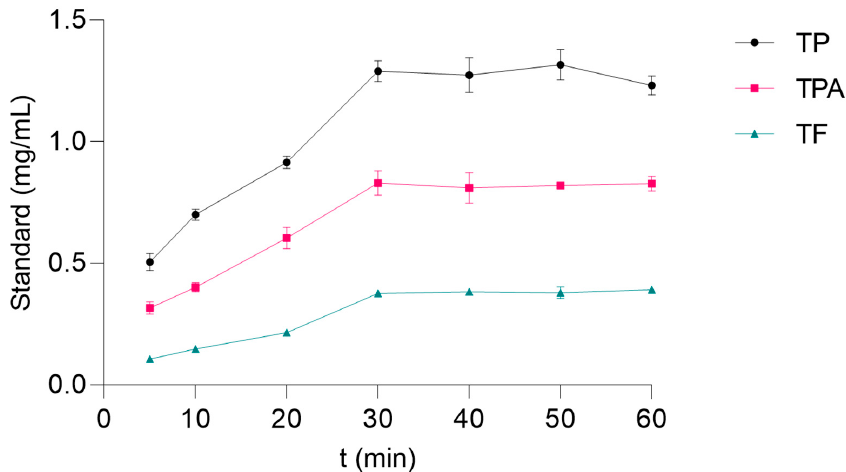
Figure 2. Kinetic plots of content of total phenolics (TP), phenolic acids (TPA), and flavonoids (TF) extracted from H. italicum using a solution of 0.6 mmol of HP- β -CD in 10 g of water. The experiments were performed in triplicate. The amounts are shown as mean ± SD. Standards: gallic acid (TP), caffeic acid (TPA), and quercetin (TF).